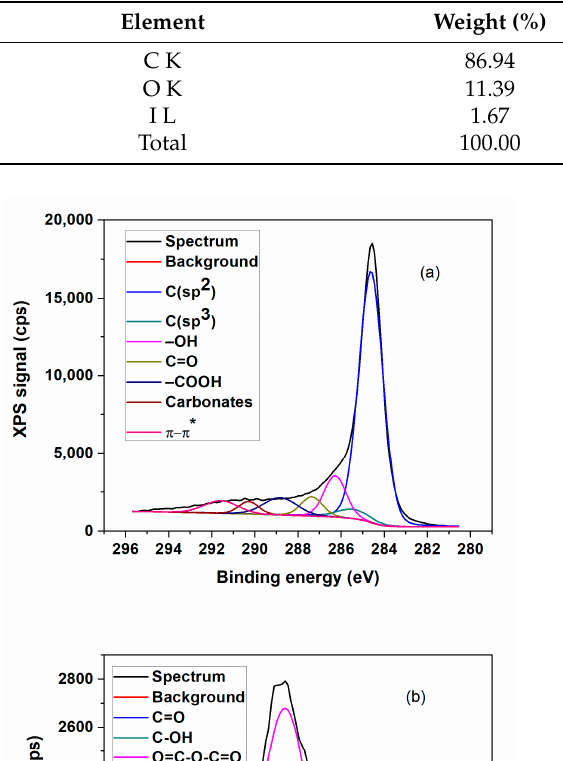
Table 1. Elemental concentration of the iodine-doped graphene sample.